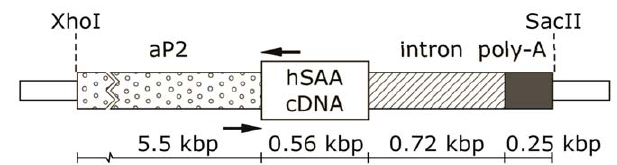
Figure 1. Generation of transgenic mice overexpressing hSAA in adipose tissue. A schematic representation of the aP2 promoter- hSAA fusion gene. Human SAA1 cDNA was ligated to the aP2 promoter/ enhancer as described in ‘‘Methods’’. Dotted box aP2 promoter, hatched box, rabbit b -globin intron, grey box, polyadenylation signal. Restriction enzyme digestion with XhoI and SacII enzymes generated fragments of 7.2 kilobases that were used in pronuclei injections. Locations of genotyping primers are indicated with